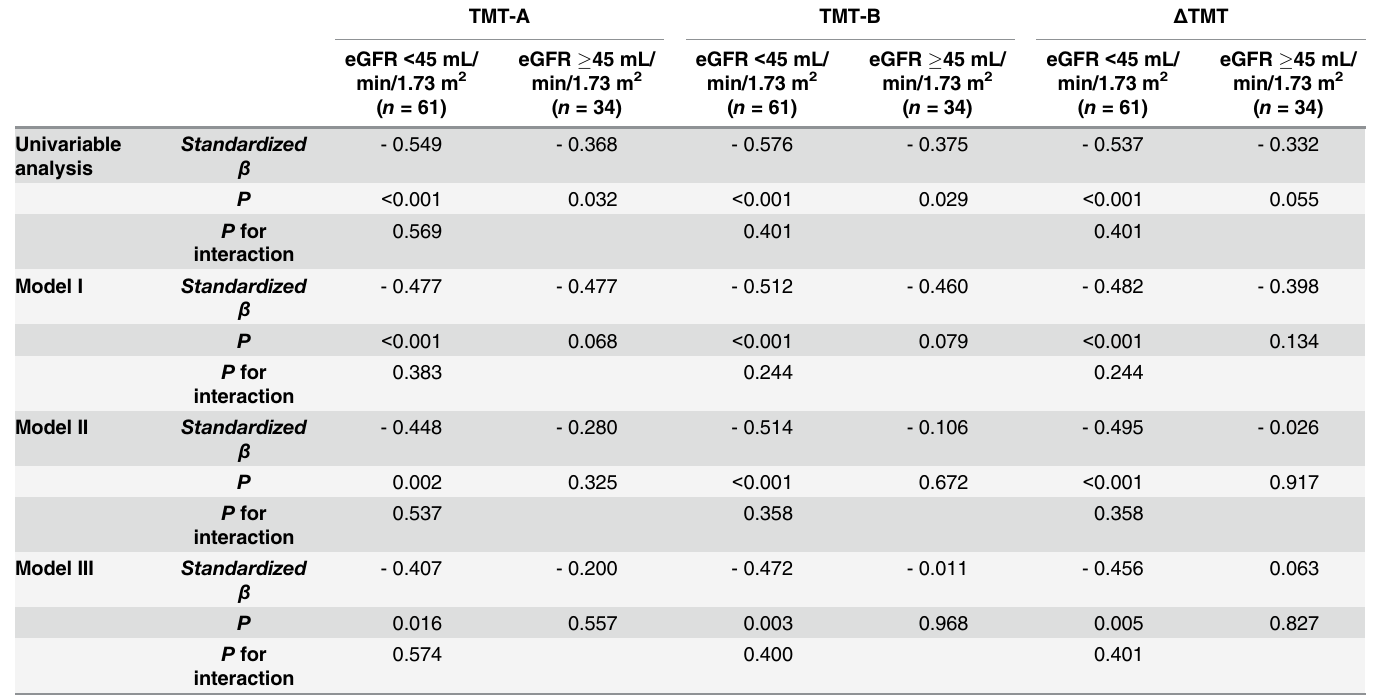
Table 4. Univariable and Multivariable-Adjusted Regression Analyses of Correlation between Normalized Whole-Brain GMV and TMT Scores in Participants Stratified by eGFR ( < 45 vs. (cid:3) 45 mL/min/1.73 m 2 ). Model I: Multivariable analysis adjusted for sex and age. Model II: Model I + diabetes melli- tus, estimated glomerular filtration rate, and education. Model III: Model II + systolic blood pressure, smoking habits, drinking habits, hemoglobin, previous history of cardiovascular disease, and log-transformed urinary protein to creatinine ratio. Abbreviations: eGFR, estimated glomerular filtration rate; TMT, Trail Making